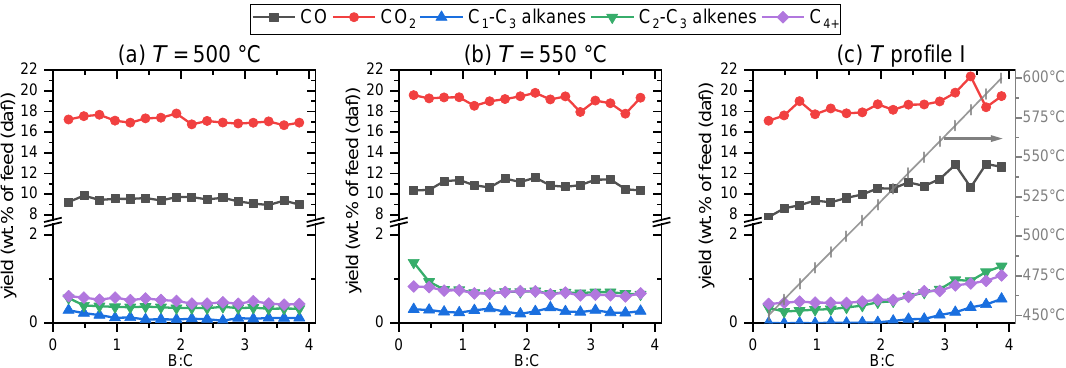
Figure 3. Change in momentary gas yields with increasing biomass injection for ( a ) a catalyst temperature of 500 °C, ( b ) a catalyst temperature of 550 °C, and ( c ) following temperature profile I. Catalyst: γ-Al 2 O 3 .